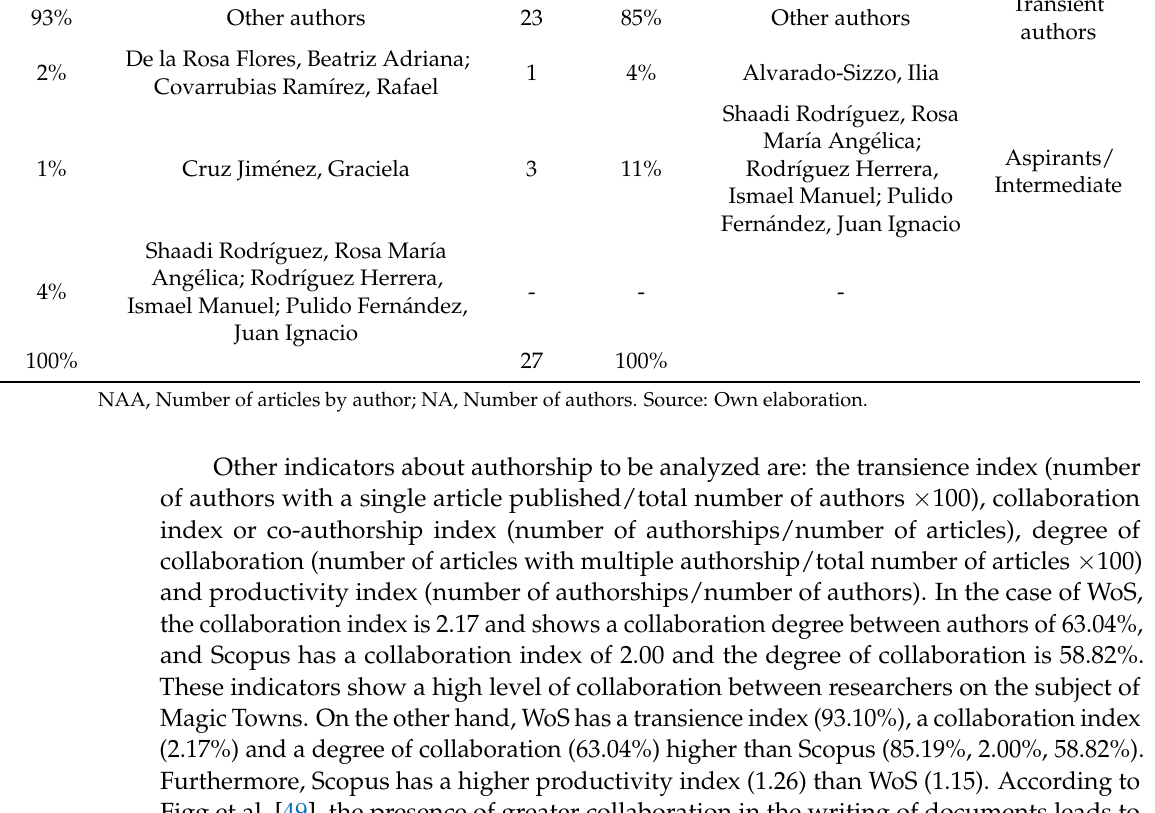
Figg et al. [49], the presence of greater collaboration in the writing of documents leads to an increase in the maturity of the discipline, while establishing the existence of a positive correlation between the number of authors and the number of citations per